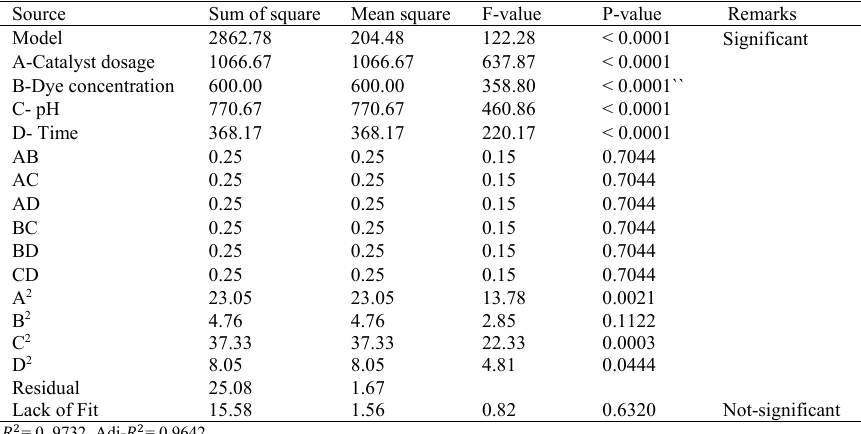
Table 4. Analysis of variance (ANOVA) results of the quadratic model.